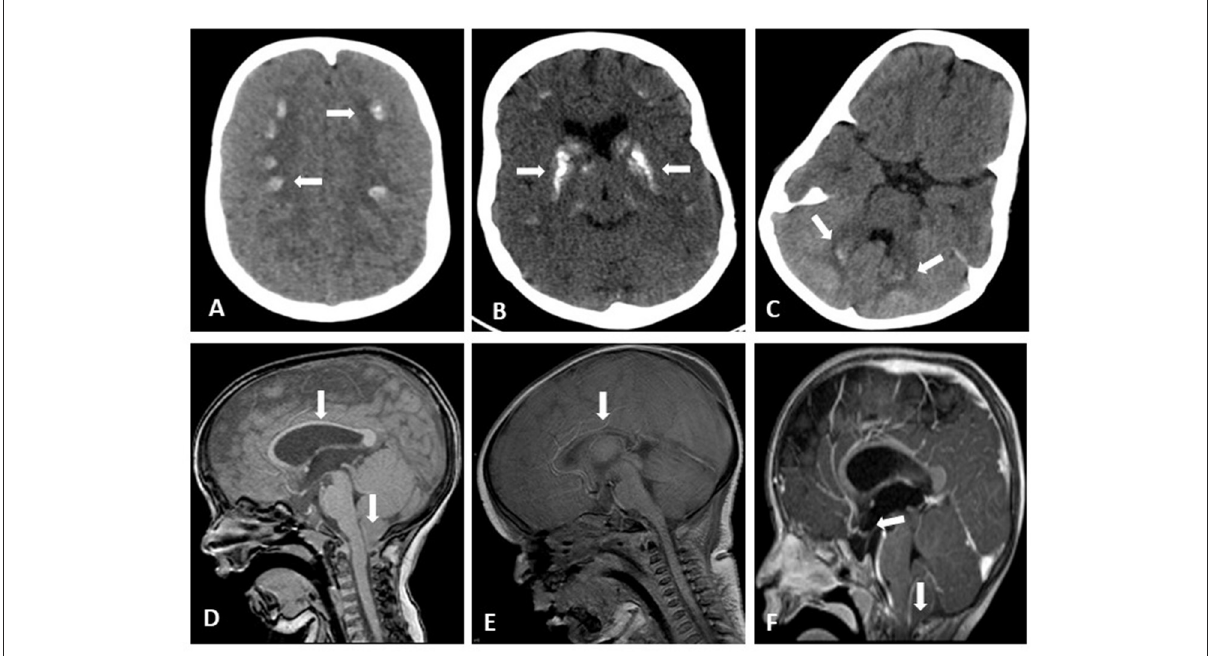
FIGURE1 Brain imaging of HRD patients. Axial brain CT without contrast showing bilateral frontoparietal calcifications (A) , bilateral basal ganglia coarse calcifications (B) small bilateral Dentate Nucleus calcifications (C) ; Sagittal brain MRI T1 without contrast showing Chiari Malformation and